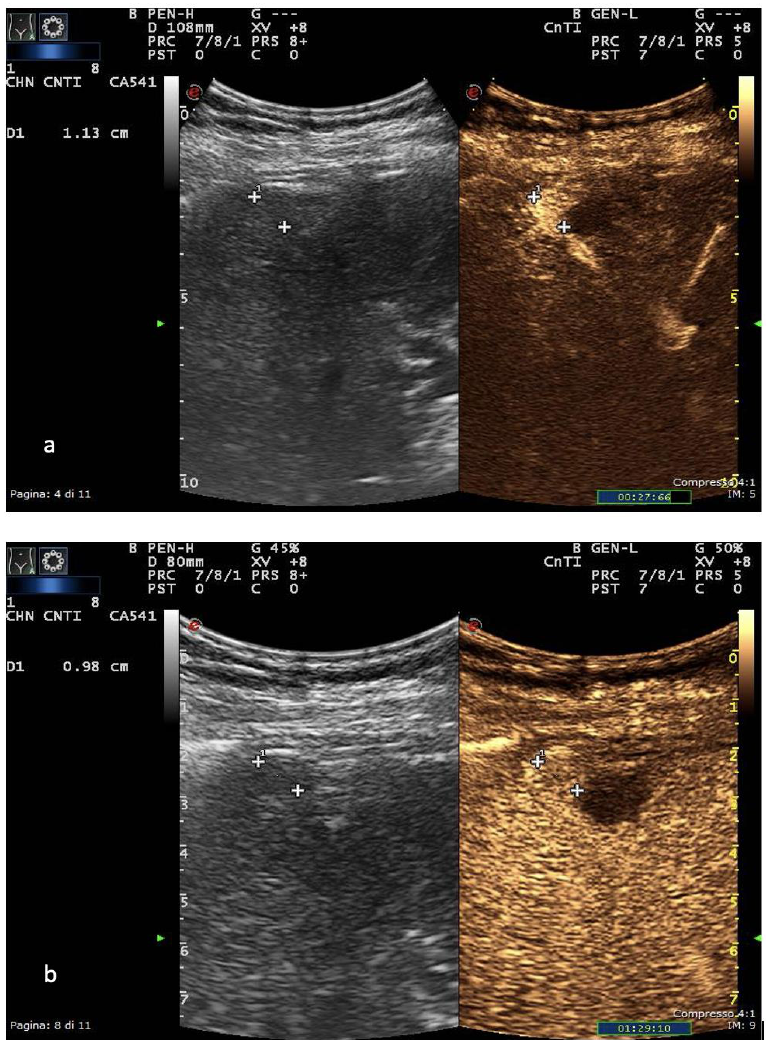
Figure 1. US and CEUS surveillance examination in a patient with HBV-related cirrhosis. Baseline images detect the presence of a centimetric subcapsular hypoechoic nodule. After administration of USCA, the lesion shows arterial hyperenhancement ( a ) with a mild portal-venous wash-out ( b ). The timing and degree of wash-out are important for the characterization of HCC, which typically shows milder hypo-enhancement compared to metastasis and cholangiocar- cinoma. Nodules measuring >5 cm may show heterogeneous enhancement due to necrosis. Both the size and the degree of differentiation affect the enhancement pattern of HCC